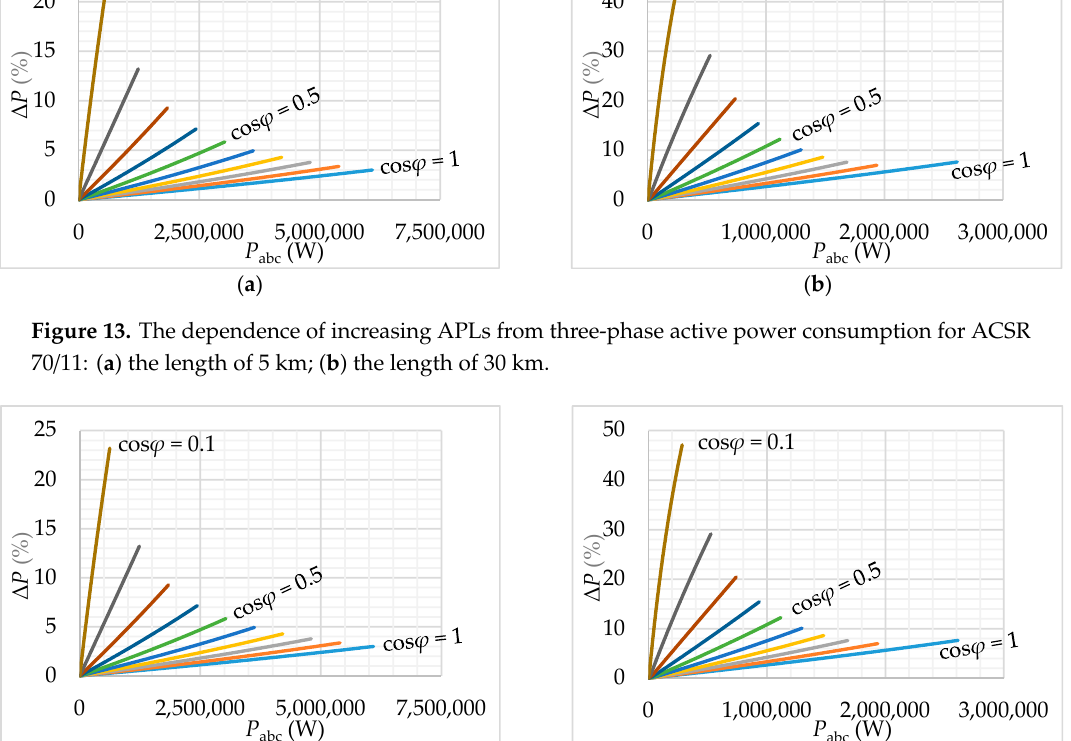
Figure 14. The dependence of increasing APLs from three-phase active power consumption for ACSR